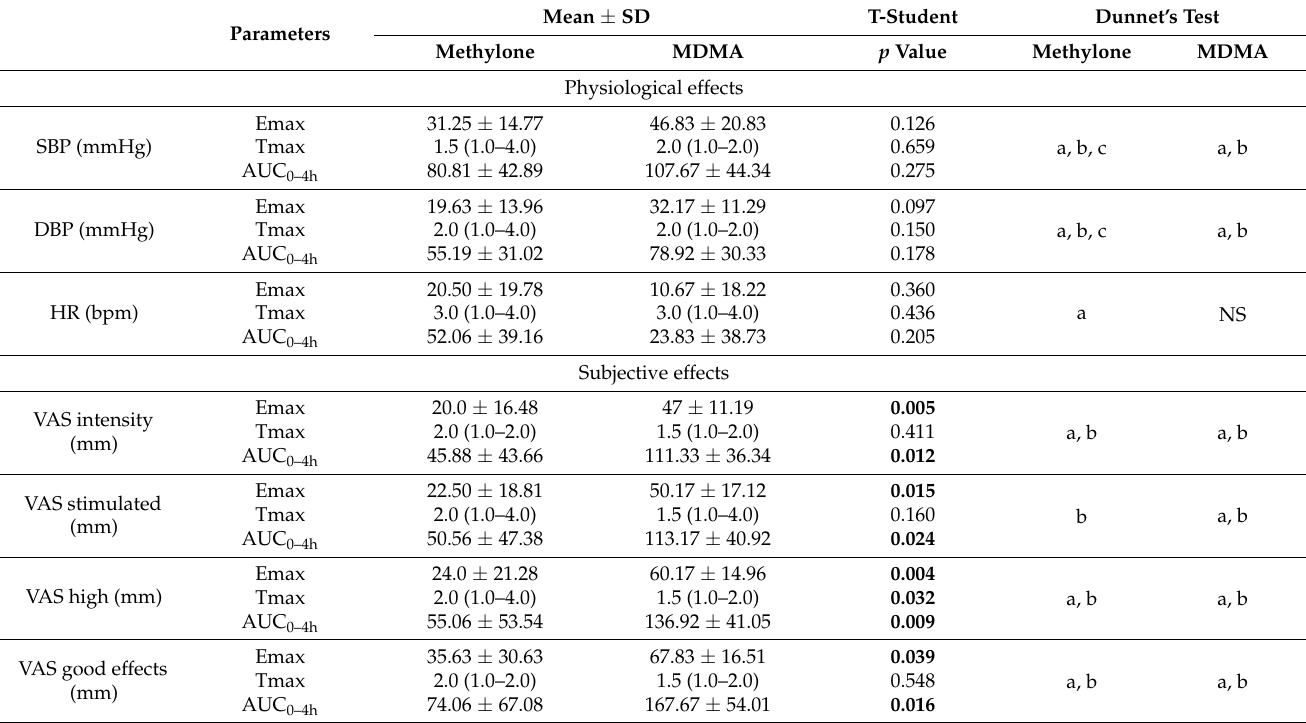
Table 1. Summary of the statistically significant results on physiological and subjective effects after methylone ( n = 8) and MDMA ( n = 6) self-administration. Only variables with some statistically significant differences in any of the parameters (Emax, Tmax, AUC 0–4h ) and Dunnett’s test are